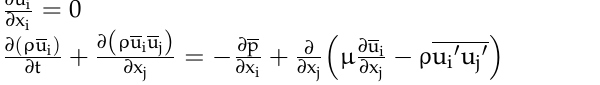
upper airfoil surface within the range of 0.7